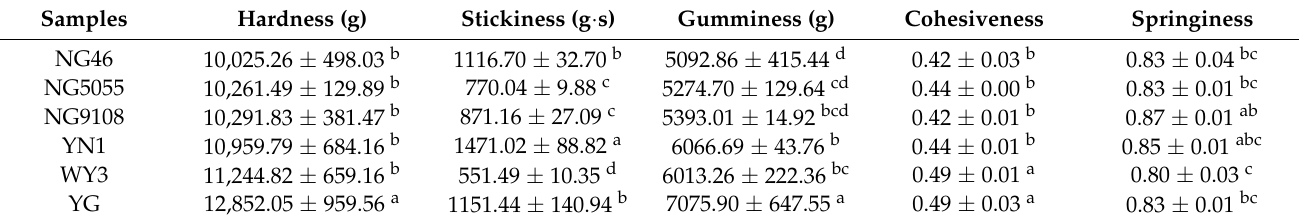
Table 3. TPA characteristic parameters for six kinds of Japonica